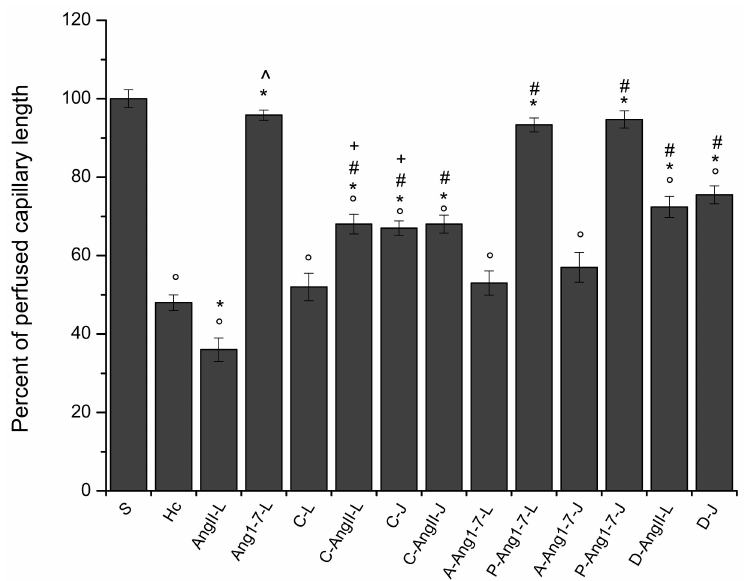
Figure 6. Changes in perfused capillaries are quantified as the length of the capillaries showing blood flow (PCL). Date are reported as percentage of the length of perfused capillaries at the end of reperfusion in the different experimental groups: Sham-operated group (S group), hypoperfused group (Hc group), Ang II local application-treated group (AngII-L group), Ang 1-7 local application- treated group (Ang1-7-L group), candesartan cilexetil local application-treated group (C-L group), candesartan cilexetil plus Ang II local application-treated group (C-AngII-L group), candesartan cilexetil intravenous infusion-treated group (C-J group), candesartan cilexetil local application plus Ang II intravenous infusion-treated group (C-AngII-J group), A779 plus Ang 1-7 local application-treated group (A-Ang1-7-L group), P123319 plus Ang 1-7 local applied-treated group (P-Ang1-7-L group), A779 plus Ang 1-7 intravenous infusion-treated group (A-Ang1-7-J group), P123319 plus Ang 1-7 intravenous infusion-treated group (P-Ang1-7-J group), diminazene aceturate plus Ang II local application-treated group (D-AngII-L group), and diminazene aceturate intravenous infusion-treated group (D-J group). Candesartan cilexetil local administration prior to Ang II preserved the capillary perfusion. Mas receptor antagonist prior to Ang 1-7 did not preserve the capillary perfusion, while AT 2 R antagonist did preserve capillary perfusion. Data are reported as mean ± SEM. ◦ p < 0.01 vs. S group, * p < 0.01 vs. Hc group, ˆ p < 0.01 vs. AngII-L group, + p < 0.01 vs. C-L group and # p < 0.01 vs. AngII:L-J groups. Statistical significance was obtained using parametric test (Bonferroni post hoc